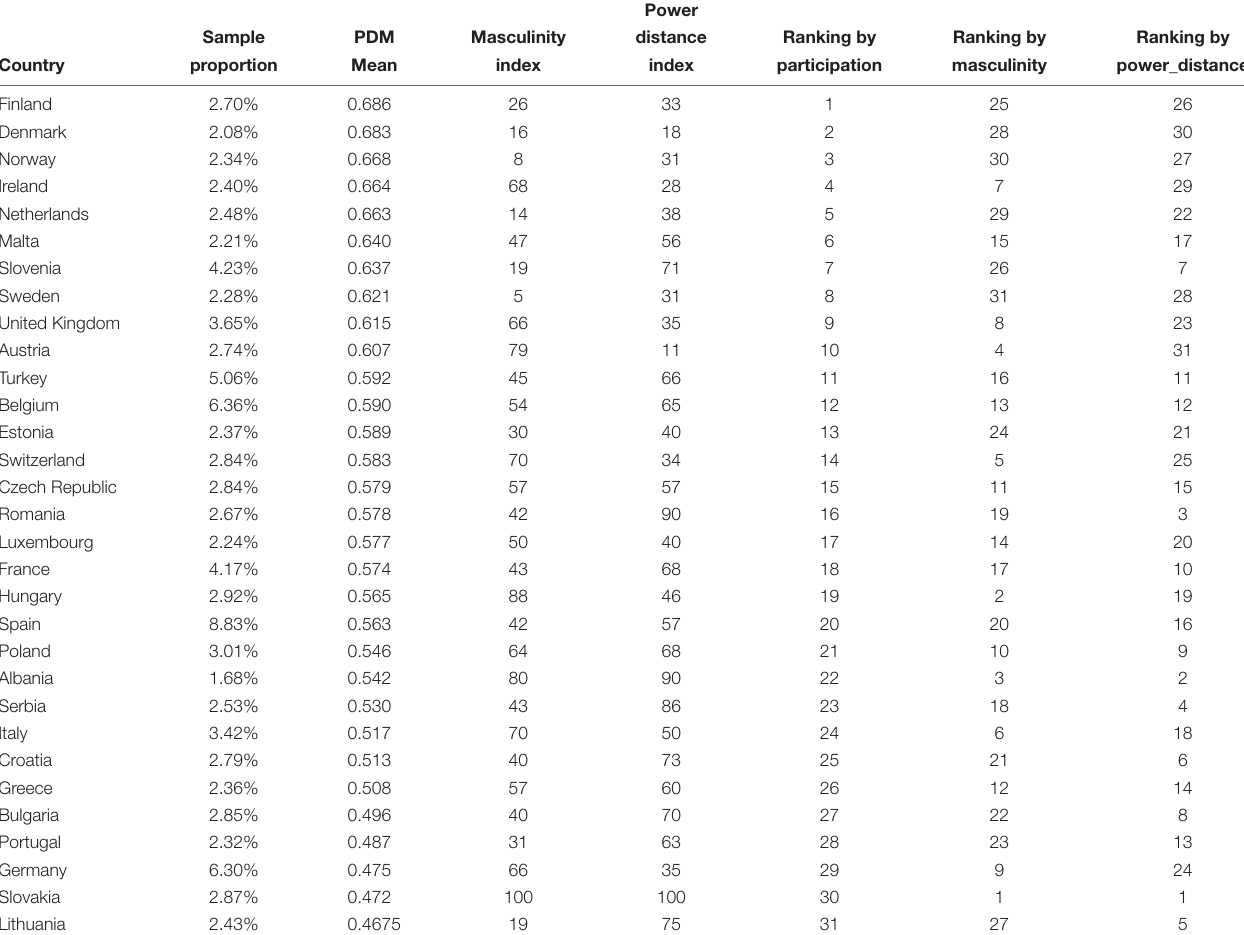
TABLE 8 | Ranking of countries according to their direct employee PDM (average) and cultural